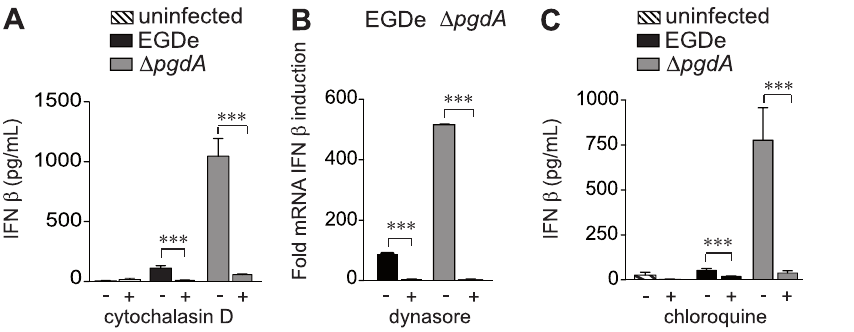
Figure 5. Internalization of bacteria is required for IFN- b response by peritoneal macrophages. (A) PEM from WT C57BL/6J mice were pretreated with 50 m M of cytochalasin D, and left uninfected (hatched bars) or infected with the parental EGDe strain (black bars) or the D pgdA mutant (grey bars). 7 h post-infection, IFN- b levels were measured in cells supernatants by ELISA. (B) PEM from WT C57BL/6J were treated with 80 m M dynasore. After 4 h of infection with the parental EGDe strain (black bars) or the D pgdA mutant (grey bars), IFN- b induction was measured by qRT- PCR. (C) PEM from WT C57BL/6J mice were treated with 100 m M chloroquine, and left uninfected (hatched bars) or infected with the parental EGDe strain (black bars) or the D pgdA mutant (grey bars). 7 h post-infection, IFN- b concentrations were measured in cells supernatants by ELISA. Data are